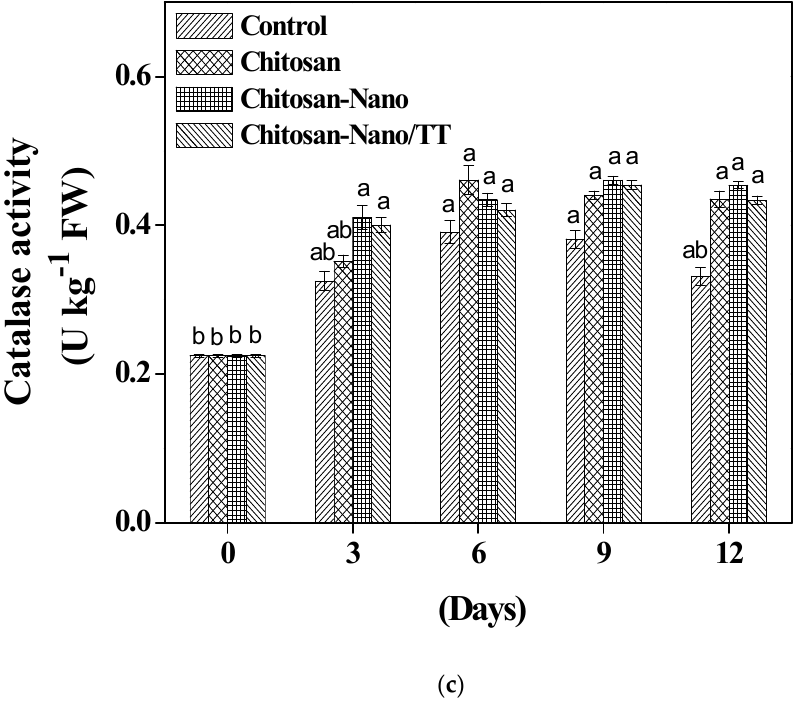
Figure 2. Effect oxidoreductase enzyme activities measured in mushroom during storage at 4 °C; peroxidase ( a ), superoxide dismutase ( b ), and catalase ( c ) activities; different small letters a;b mean significant differences between treatments at p ≤ 0.05.